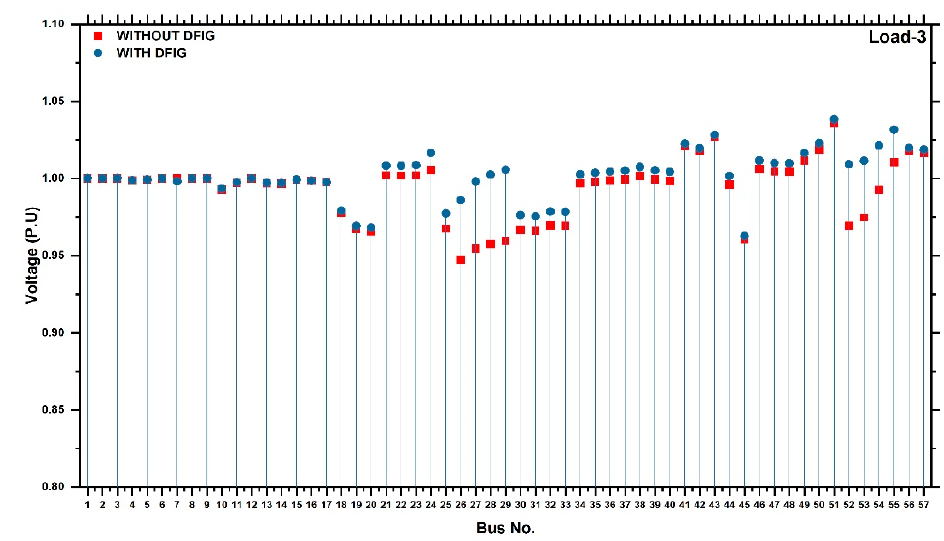
Figure 9. Voltage profile with and without a DFIG of Load 1, Load 2 and Load 3.